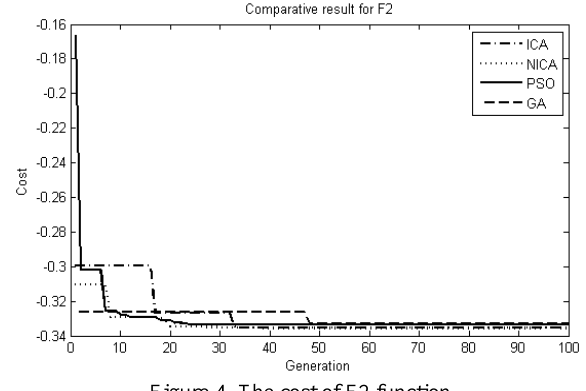
Figure 4. The cost of F2 function